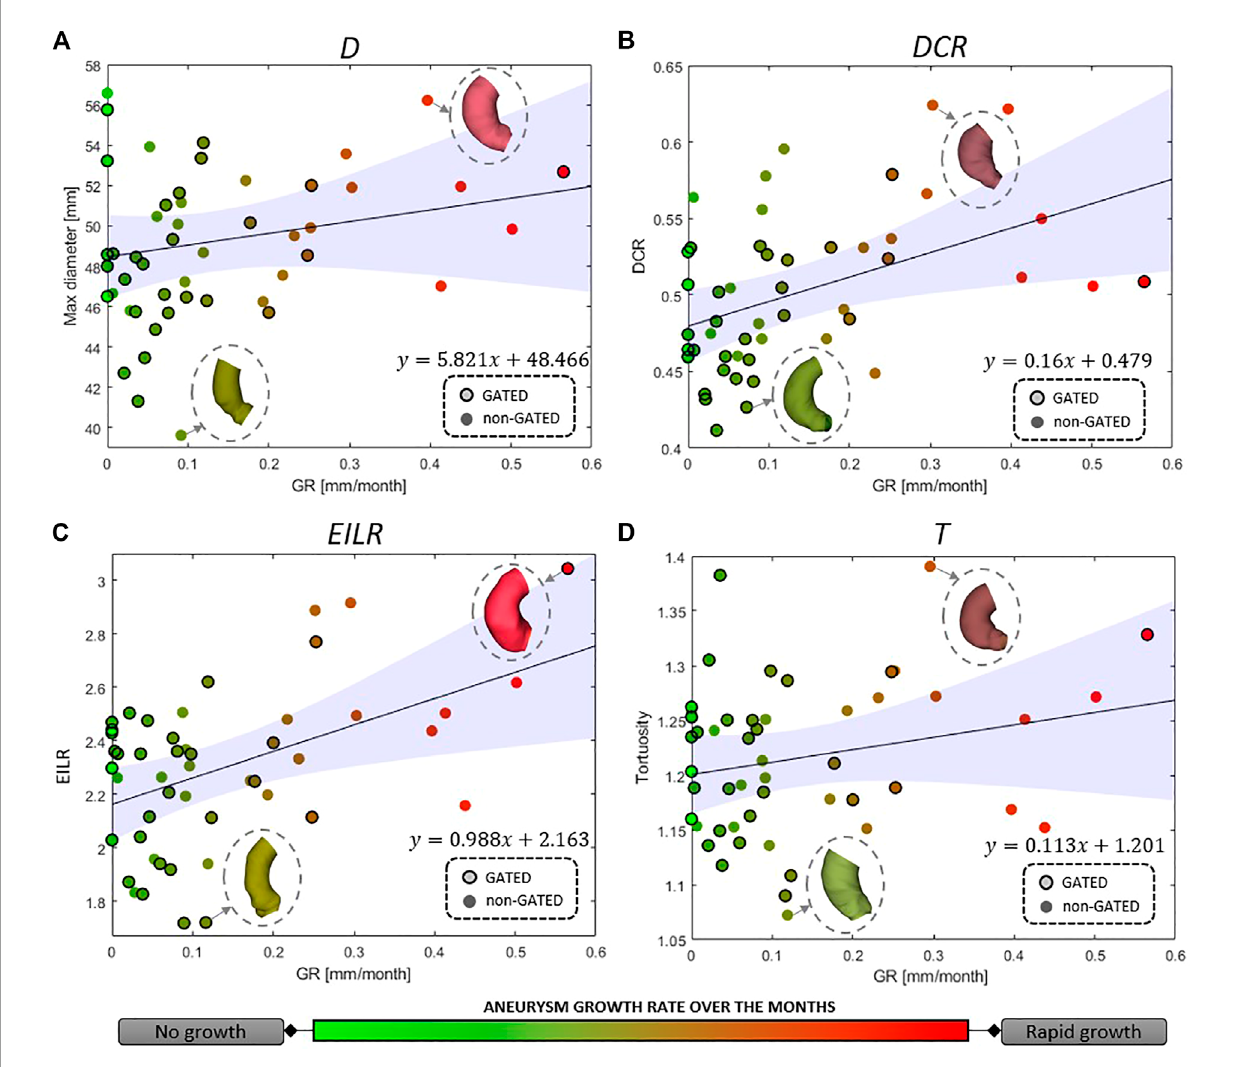
FIGURE 3 Correlation between growth rate and (A) maximum aneurysm diameter D , (B) ratio of maximum diameter and centerline length DCR , (C) ratio of external and internal curvature line length EILR and (D) tortuosity T . The circles around the marker edges indicate patients with two gated acquisitions in the same phase of the cardiac cycle. The line for linear correlation with 95% fitting confidence bounds is reported, the fitting equation provided and some of the AAo shapes